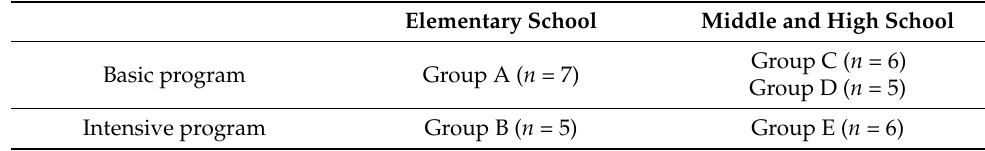
Table 2. Composition of focus